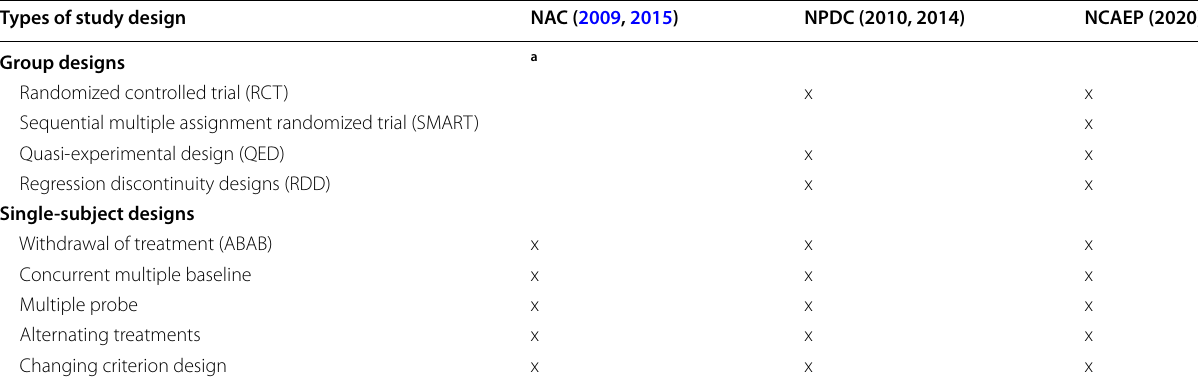
a In NAC’s 2009 and 2015 reports, the types of group designs that composed the revised sample were not specified